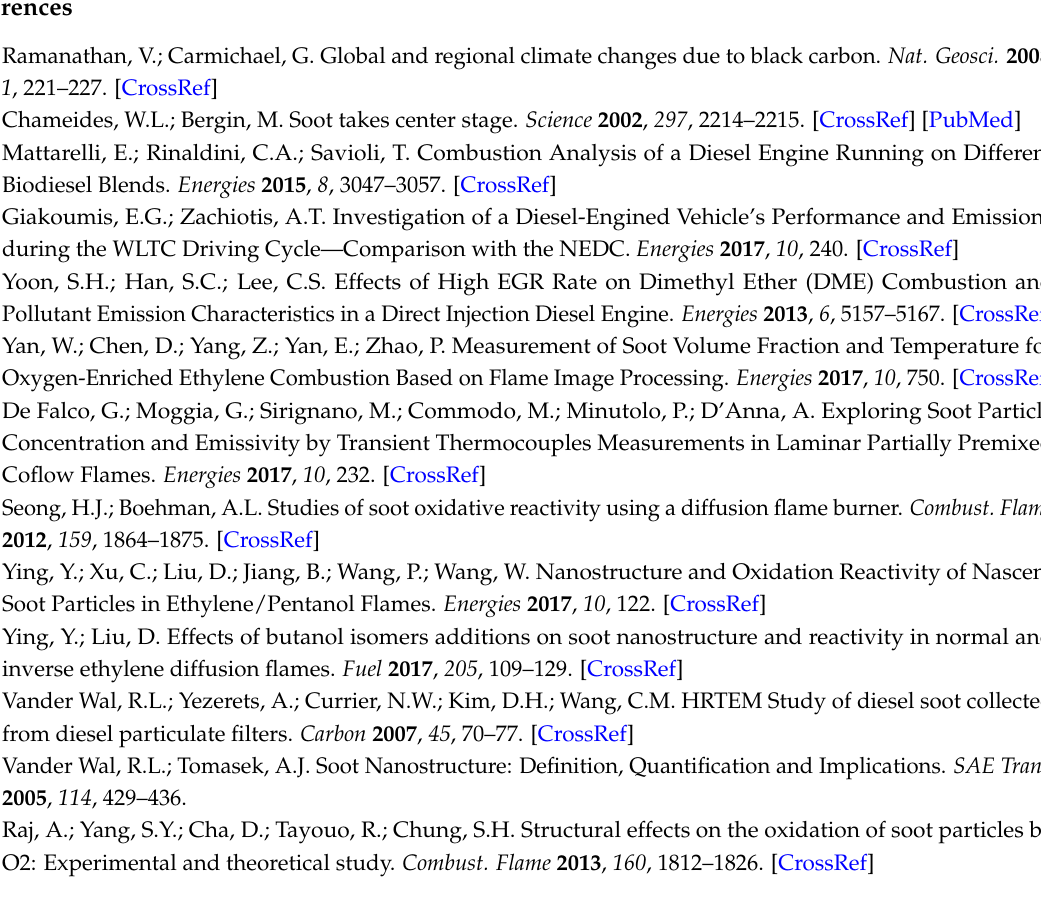
Figure S1: Flow chart of HRTEM image processing. Figure S2: HIM images, typical TEM images and HRTEM images of F air 1 and F ar 1. ( a ) HIM image of F air 1; ( b ) typical TEM image of F air 1; ( c ) HRTEM image of F air 1; ( d ) HIM image of F ar 1; ( e ) typical TEM image of F ar 1; ( f ) HRTEM image of F ar 1. Figure S3: Histograms of fringe length, tortuosity and separation for F air 1 and F ar 1. Figure S4: Oxidative behaviors for the three samples. ( a ) CO mole fraction of three samples in TPO experiments; ( b ) CO 2 mole fraction of three samples in TPO experiments; ( c ) TGA results of isothermal oxidation for three samples at 500 ◦